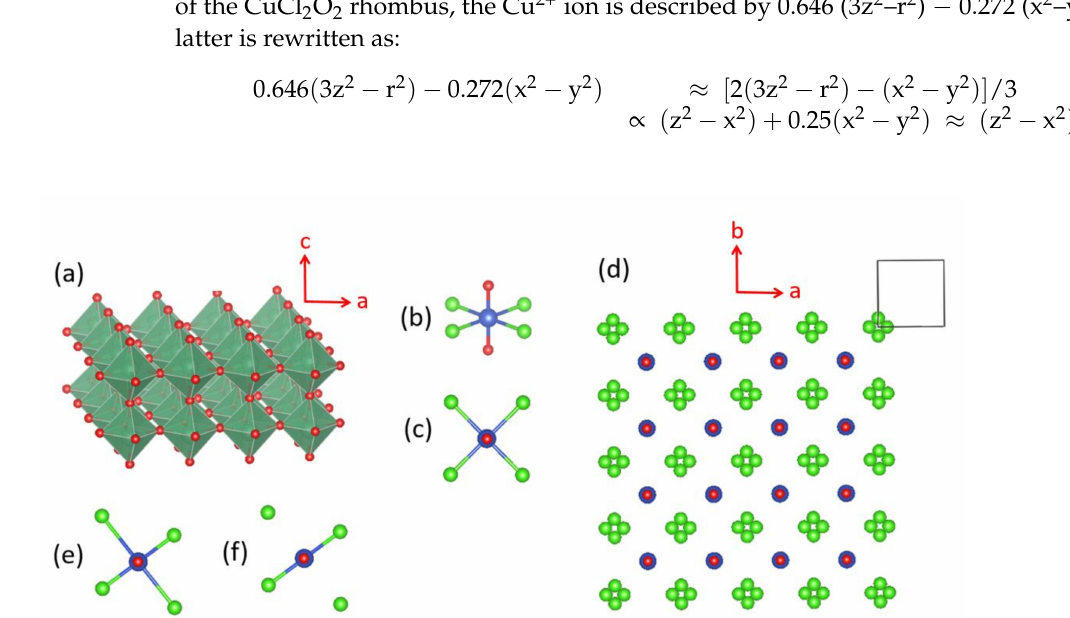
Figure 16. ( a ) One LaNb 2 O 7 layer of tetragonal (CuCl)LaNb 2 O 7 , where the La atoms at the 12 coordinate sites formed by eight corner-sharing NbO 6 octahedra are not shown for simplicity. ( b ) Perspective and ( c ) projection views of a CuCl 4 O 2 octahedron with 4-fold rotational symmetry around the O–Cu–O axis aligned along the c-direction. ( d ) A projection view of a CuClO 2 layer of tetragonal (CuCl)LaNb 2 O 7 in which every Cl site is split into four positions. ( e , f ) Projection views of the Jahn–Teller distorted CuCl 4 O 2 octahedron, where the axially elongated Cu–Cl bonds are shown in ( e ), but are not shown in ( f ) for simplicity.